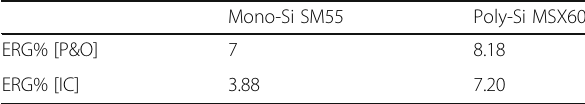
Table 3 Relative energy gains in terms of the annual produced energy. Base case: